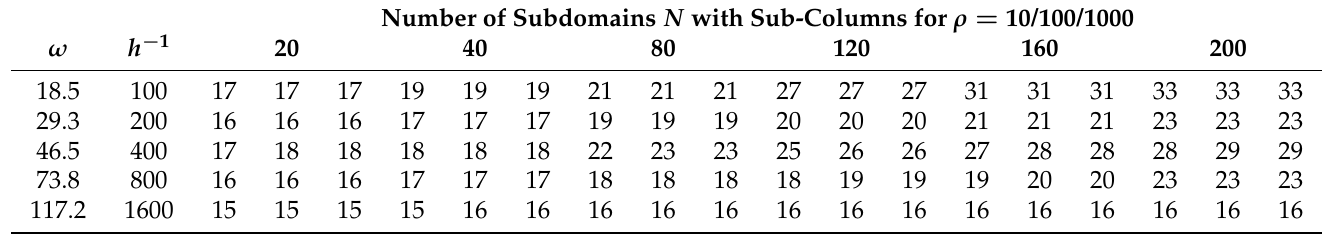
Table 7. Preconditioned GMRES iteration counts for the heterogeneous alternating layers problem with ρ = 10/100/1000 when using ORAS with H-GenEO( 1 ) and a varying number of subdomains. 2 A non-uniform decomposition into N subdomains is used, given by METIS. Number of Subdomains N with Sub-Columns for ρ =